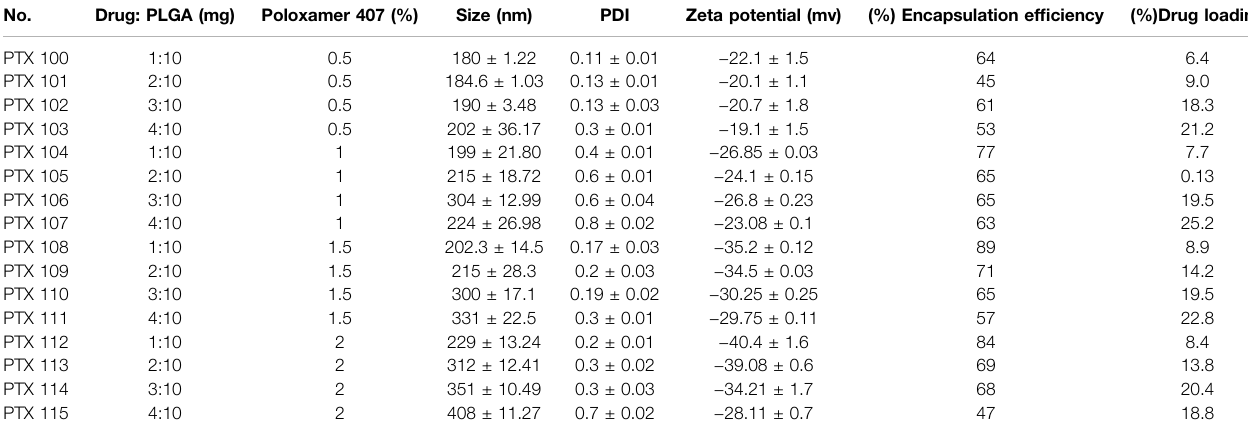
TABLE 4 | Formulation of paclitaxel with PLGA, 0.05% SLS, and poloxamer 407. No.